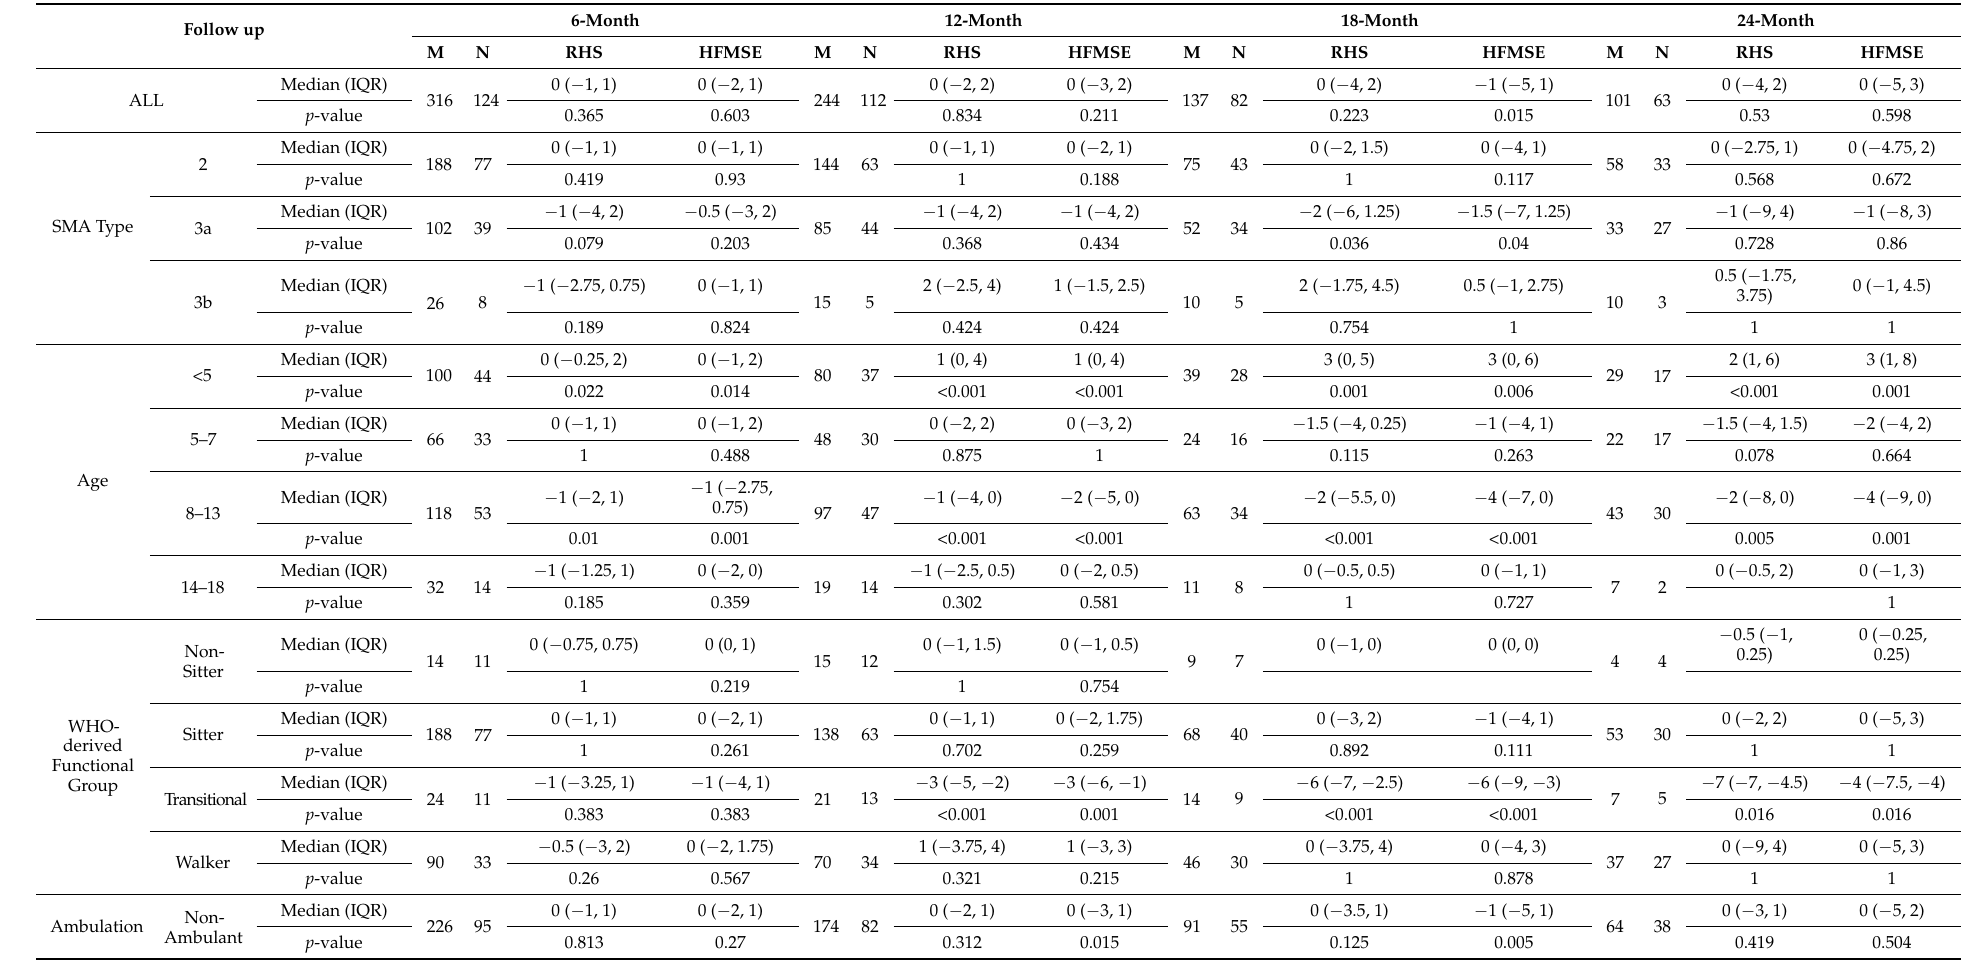
Table 2. Up to 2-year median change in the RHS and HFMSE broken down by SMA type, age, and motor function group. N : number of participants, M : number of assessments, IQR : inter-quartile